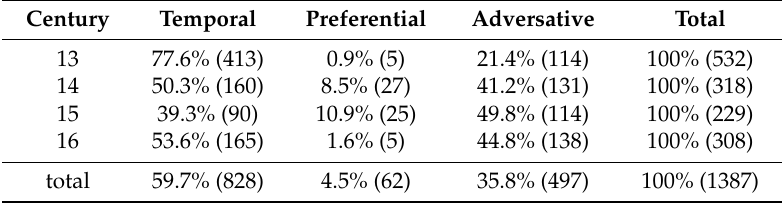
Table 3. Frequencies of temporal, preferential and adversative meaning per century.